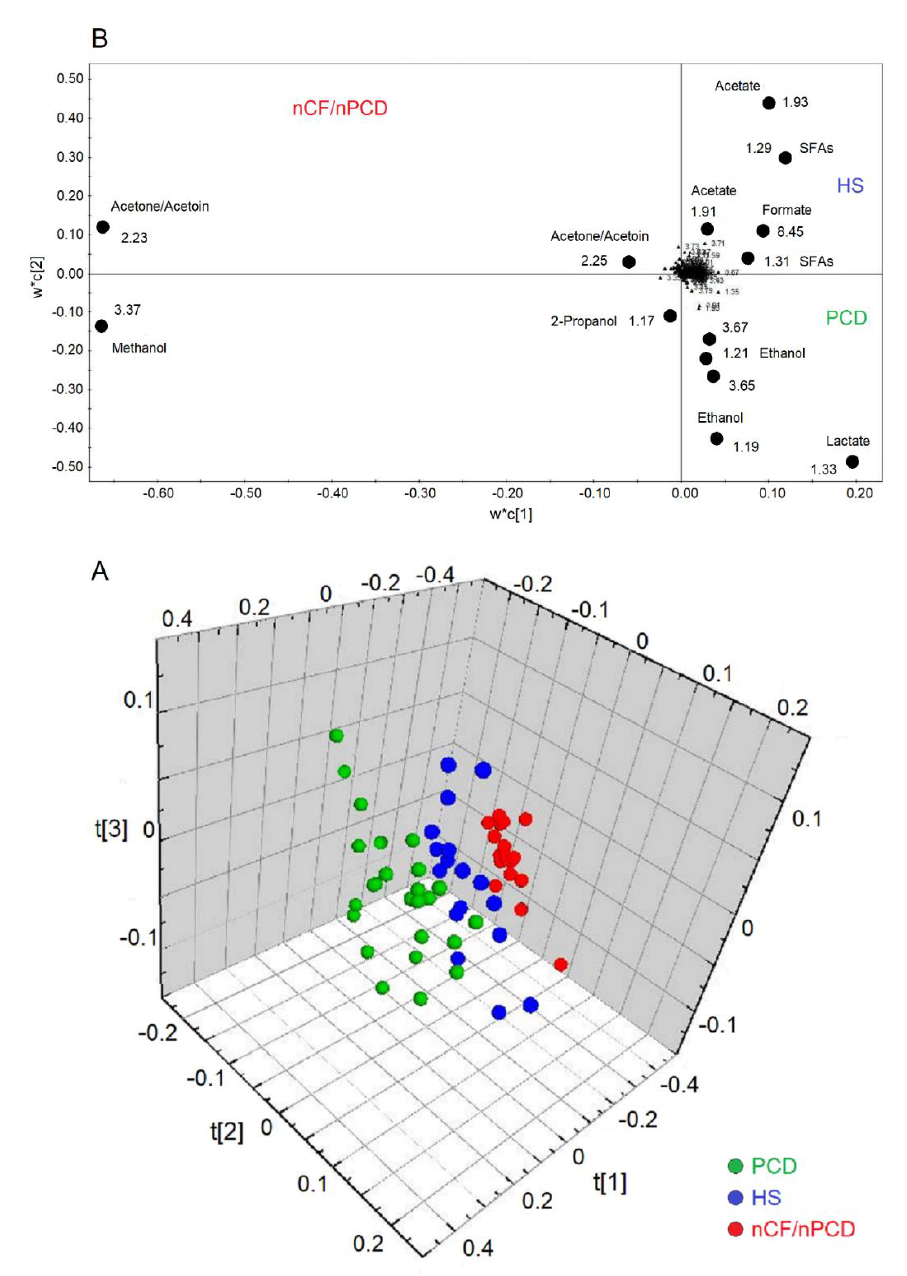
Figure 5. Orthogonal projections to latent structures discriminant analysis (OPLS-DA) of EBC samples for the PCD, nCF/nPCD bronchiectases, and HS comparison. ( A ) Three-dimensional scores plot showing the degree of separation of the model considering PCD (green dots) and nCF/nPCD bronchiectases (red dots), and HS (blue dots). The model presents strong regression (95%, p < 0.0001) with the following quality parameters, R 2 = 83.32% and Q 2 = 79.00%. t[1], t[2], and t[3] along the axes represent the scores (the “first three partial least squares components”) of the model, which are sufficient to build a good regression model. ( B ) Loadings plot associated with the OPLS-DA analysis reported in ( A ), showing the metabolites responsible for the between-class separation. For clarity, the loadings plot is reported in two dimensions. Numbers refer to buckets’ chemical shifts, and the discriminating metabolites (black dots) are explicitly labeled. Table 3. Discriminating metabolites for the OPLS-DA model comparing data from healthy subjects, cases with nCF/nPCD and PCD bronchiectasis (see Figure 5 for details). Reported metabolites increase with respect to other classes a .